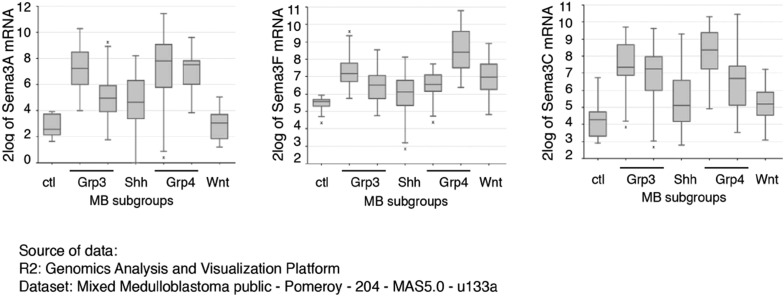
Sema3 expression levels are elevated in medulloblastoma.Multiple isoforms of Sema3 expression levels are elevated in medulloblastoma. Data are RNA-seq results from 204 patient samples, and were originally published in Cho et al., J. Clin. Oncol. 2011, 29: 1424.